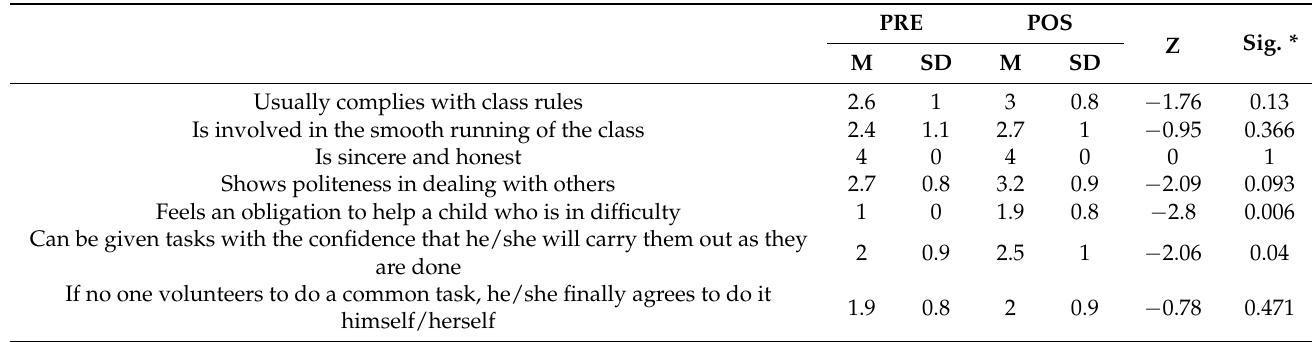
Table 12. Social